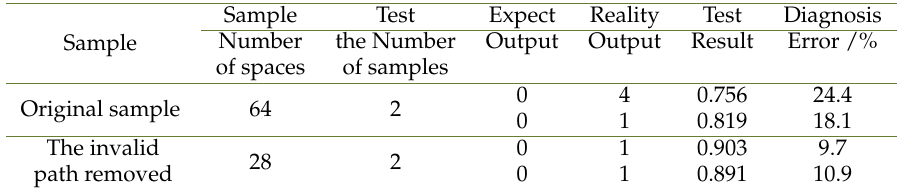
Table 5. Training results